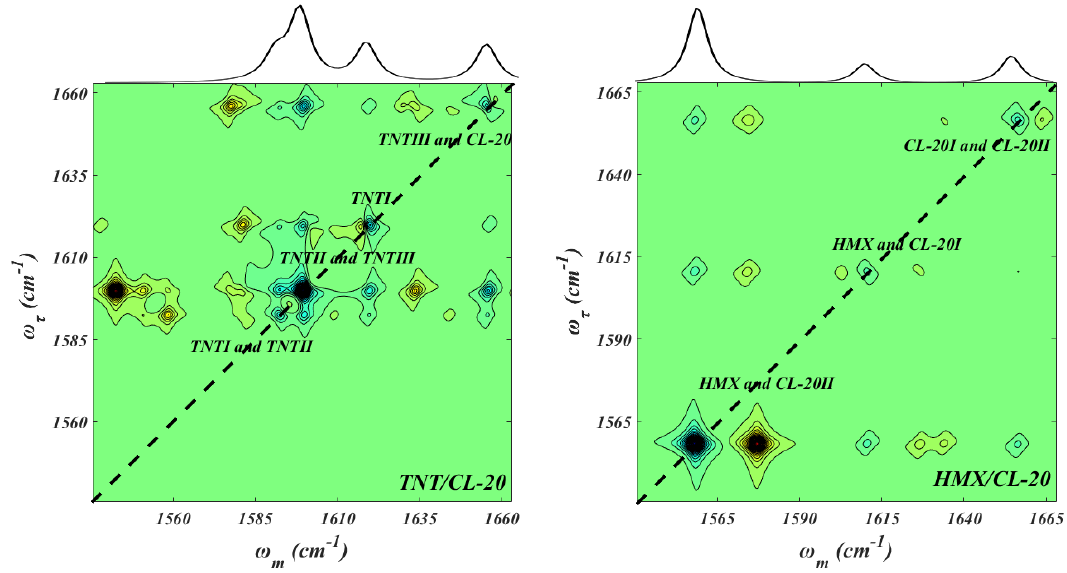
Figure 3. Normalized and simulated 2D IR spectra and corresponding IR spectra (top panel) of NO 2 asymmetric stretching in TNT/CL-20 ( left ) and HMX/CL-20 ( right